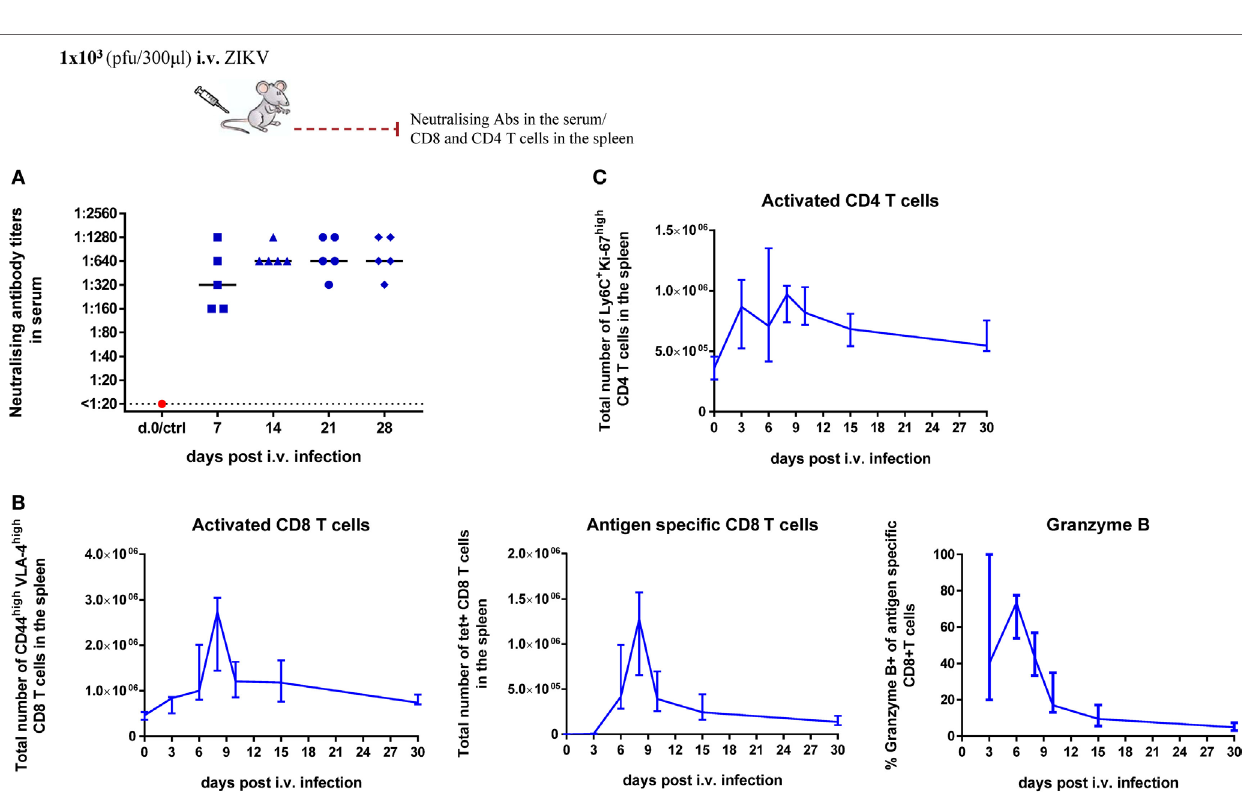
FigUre 5 | Cellular and humoral responses to Zika virus (ZIKV) infection in wild-type (WT) mice. WT C57BL/6 mice were inoculated with 1 × 10 3 pfu ZIKV i.v. On days 7, 14, 21, and 28 post i.v. inoculation, sera were collected and ZIKV-specific Abs were determined by an in vitro plaque reduction assay. Each dot represents one mouse; bars denote group medians (a) . On days 3, 6, 8, 10, 15, and 30 post i.v. inoculation, spleens were harvested and total numbers of activated (CD44 high VLA-4 high ) CD8 T cells, total numbers of antigen-specific [tetramer + (H-2D b /E 294–302 )] CD8 T cells as well as the percentage of antigen-specific CD8 T cells producing granzyme B were determined by flow cytometry (B) . On same days as in panel (B) , splenocytes were stained with anti-CD4 and Th1 polarized (Ly-6C high ) cycling (Ki-67 + ) CD4 T cells were enumerated. Panels (B, c) depict medians and ranges; n = 5–10 mice/time point (c) .